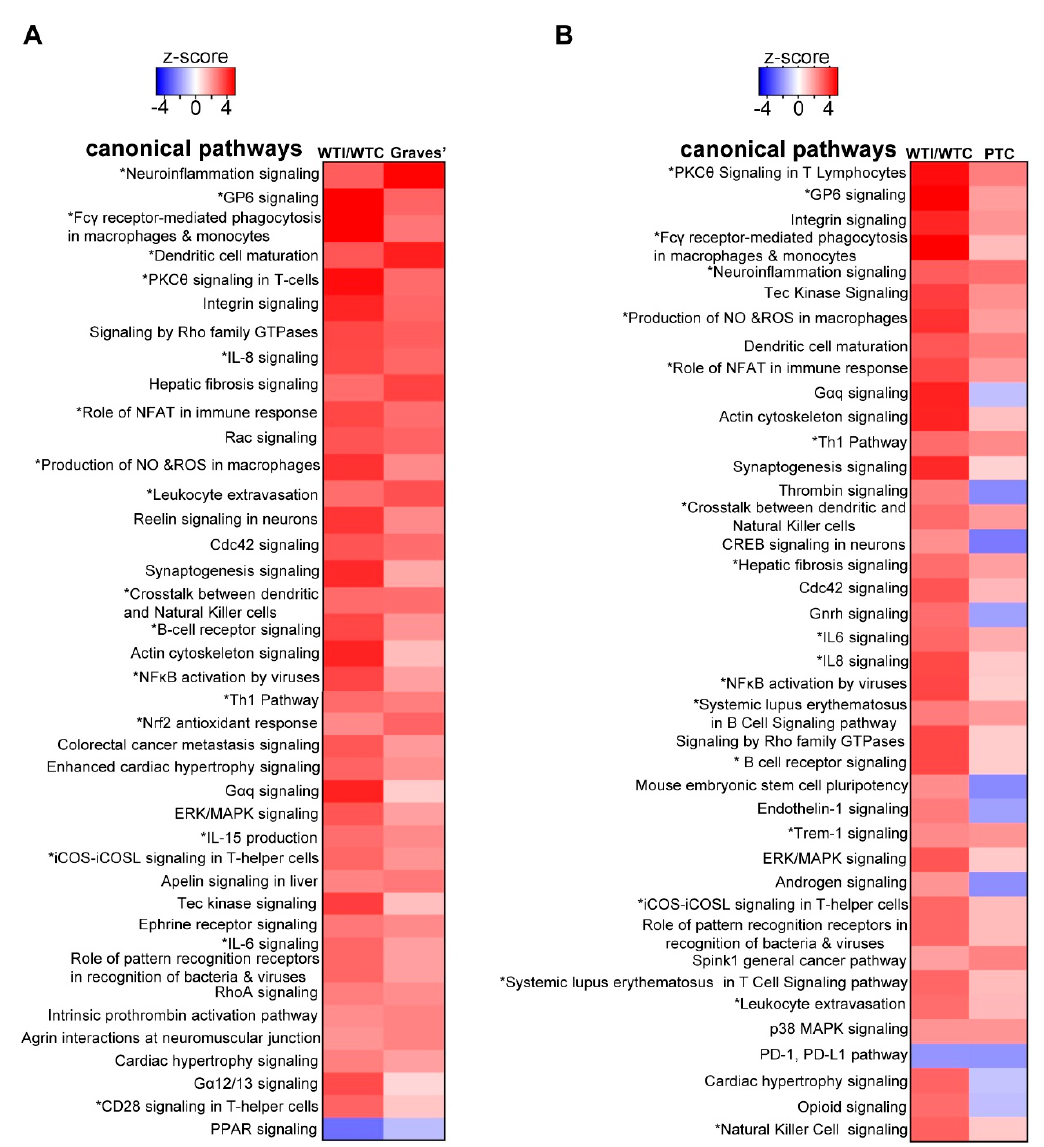
Figure 10. Comparison analyses using IPA of the top 40 enriched canonical pathways ( z -score ≥ 2 and p < 0.05) in the thyroid in different pathophysiological settings. ( A ) Comparison of WT iodide-treated vs. non-treated mice (WTI/WT) and a genetic mouse model of Graves’ disease vs. respective WT controls (publicly available at Gene Expression Omnibus GSM955426-GSM955427). ( B ) Comparison of WT iodide-treated vs. non-treated mice (WTI/WT) and of human papillary thyroid carcinoma (PTC) vs. non-cancerous thyroid tissue from the same patient (publicly available at Gene Expression Omnibus GSM77362-GSM77379).